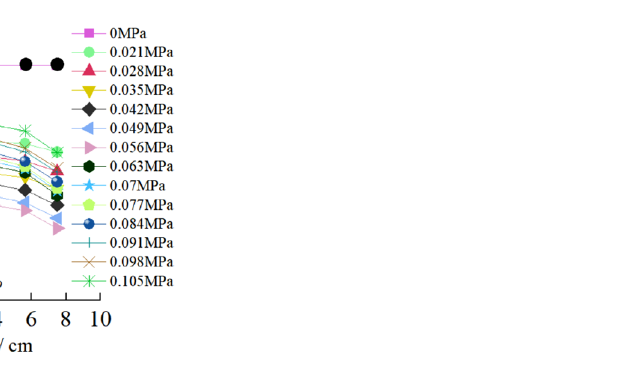
Figure 11. Evolution of floor heave of roadway with